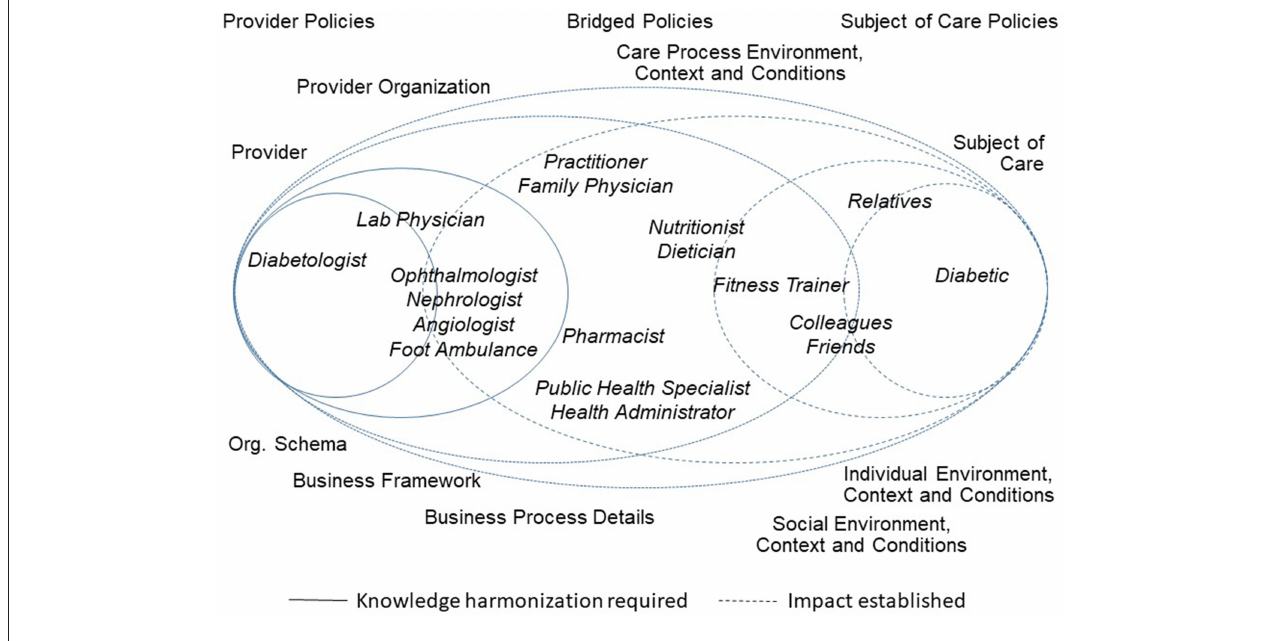
FIGURE 1 | Paradigm changes in healthcare